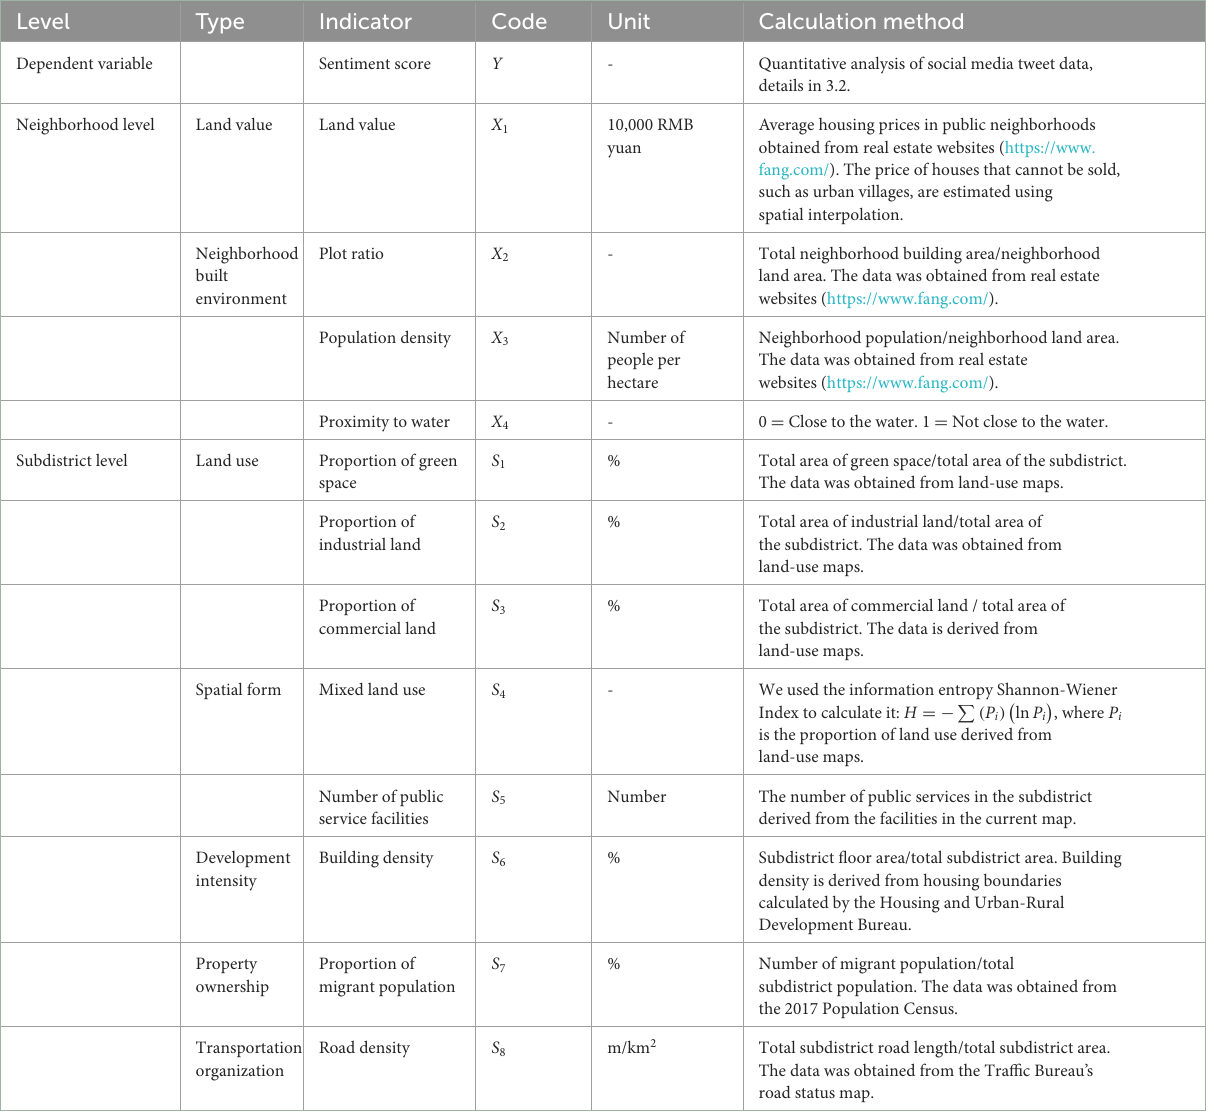
TABLE 2 Research variables and their calculation